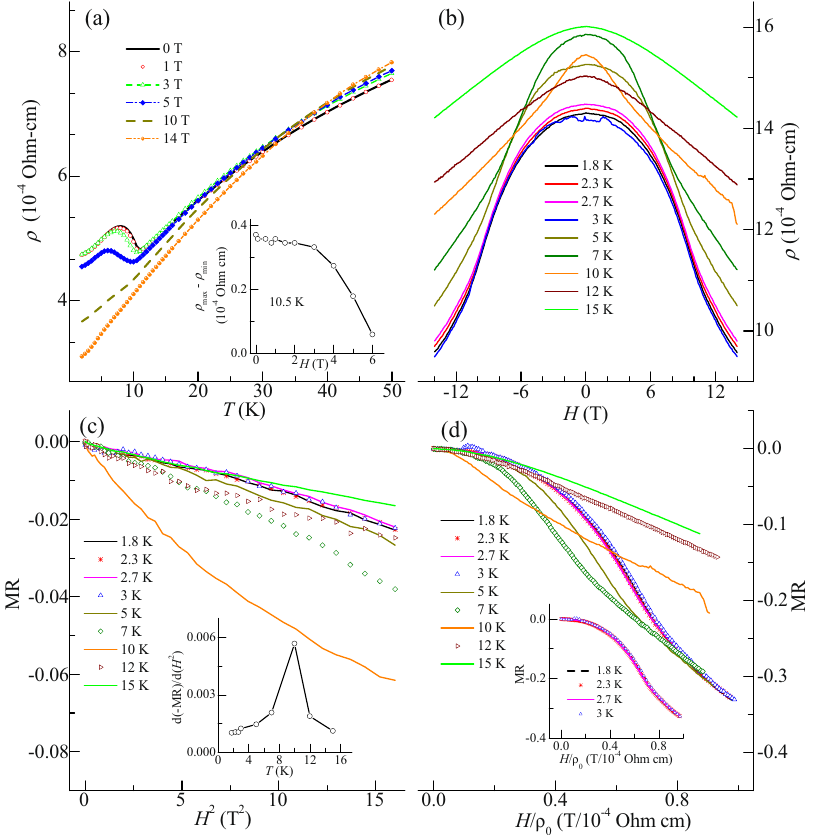
Figure 5. ( a ) Temperature dependent resistivity ( ρ ) in field range of 0–14 T. Inset: Magnetic field dependent resistivity ( ρ max − ρ min ) at T I . ( b ) DC magnetic field (14 to − 14 T) dependent resistivity in temperature range of 1.8–15 K. ( c ) H 2 dependent magnetoresistance (MR) at similar temperatures. Inset: Temperature dependent d( − MR)/d( H 2 ). ( d ) H / ρ 0 dependent MR at similar temperature. Inset: Scaling of Kohler’s